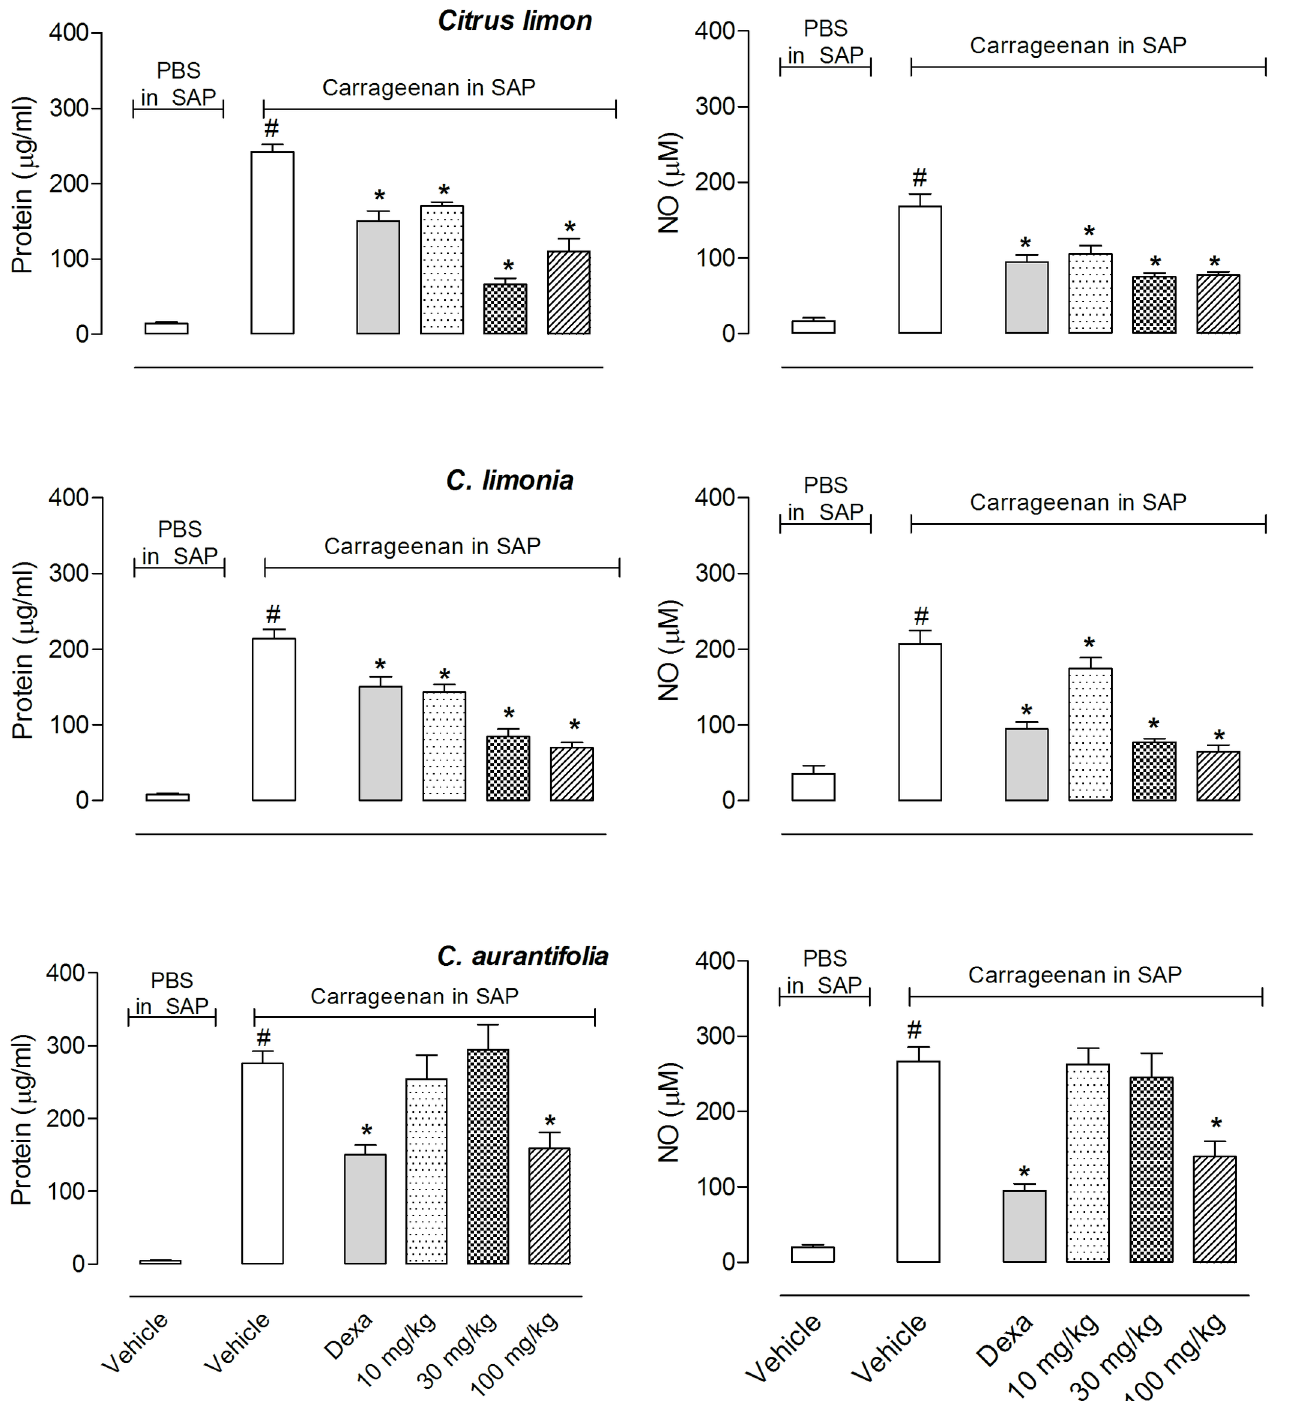
Fig 4. Effects of C . limon , C . limonia and C . aurantifolia essential oils on carrageenan-induced protein extravasation and nitric oxide (NO) production in a subcutaneous air pouch (SAP). Animals were pre-treated with various doses (10, 30 or 100 mg/kg, p.o.) of EO, dexamethasone (5 mg/kg, i.p.) or vehicle. The results are presented as the mean ± S.D. (n = 10 per group). Statistical significance was calculated by ANOVA followed by Bonferroni ’ s test. # P < 0.05 when comparing the carrageenan-injected group with the PBS-injected group and * P < 0.05 when comparing EO or dexamethasone-treated groups with the vehicle-treated